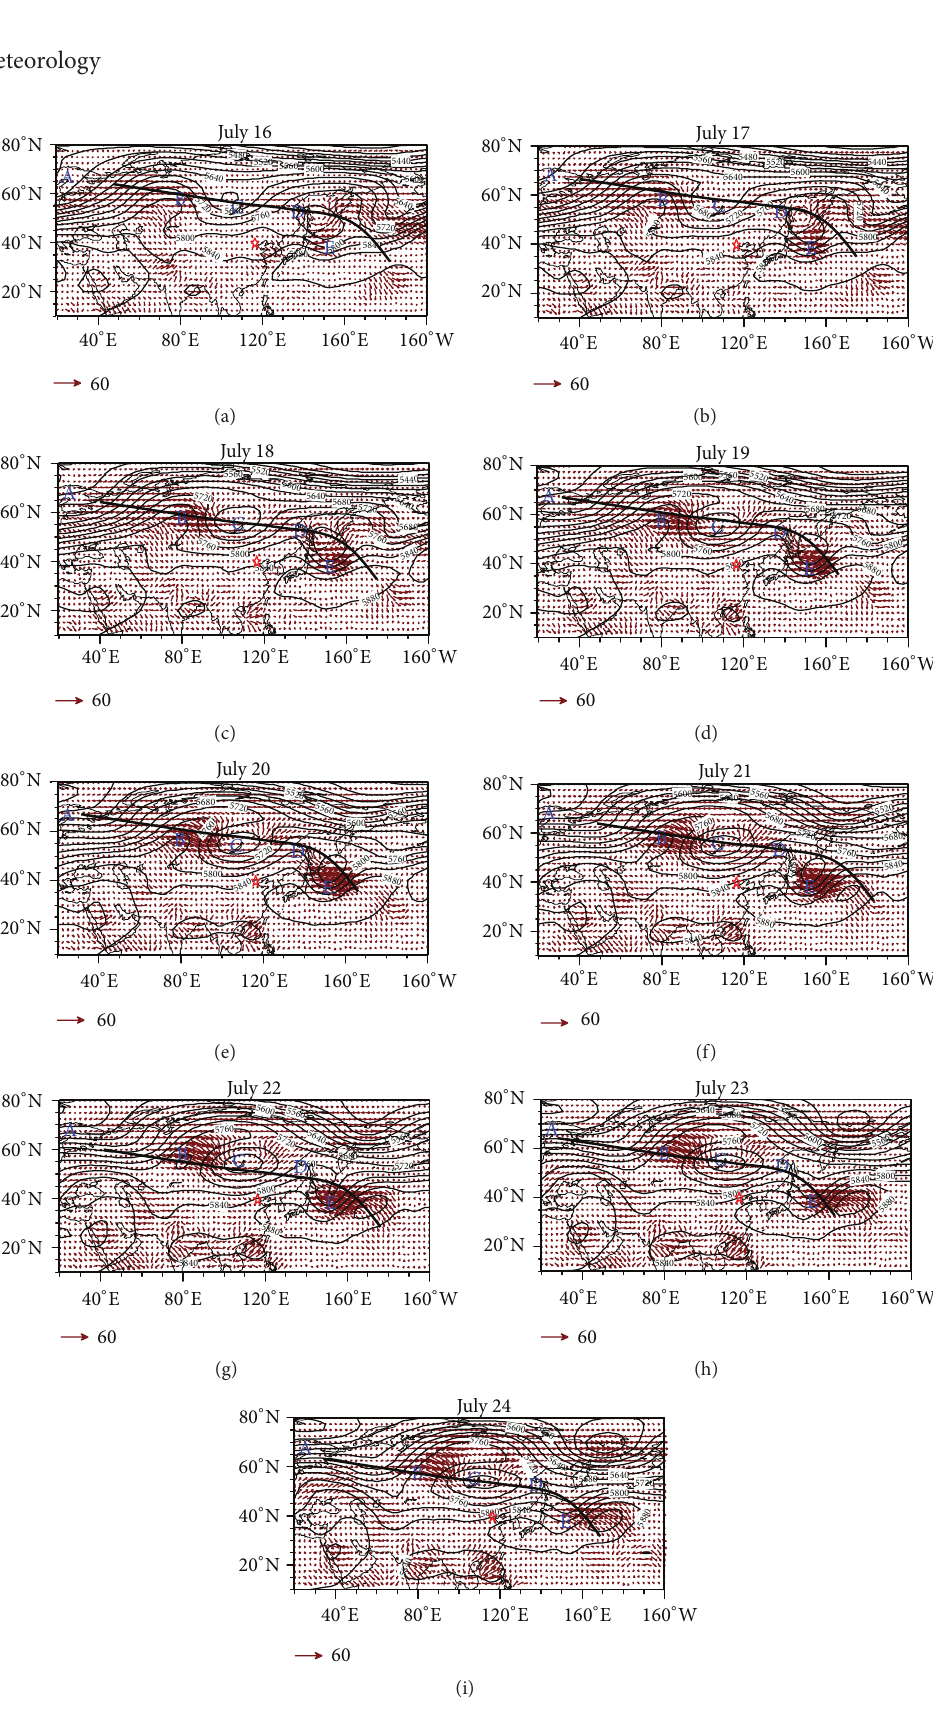
Figure 4: 500 hPa geopotential height (contour, interval: 40 gpm) and HWAF fields (vector, unit: m 2 s −2 ) on July 17–25 (a–i), 2012. The thick arch line is the OKJ track, that is, the route of strong wave activity flux from higher latitudes to southern China. The red pentagrams are on behalf of Beijing